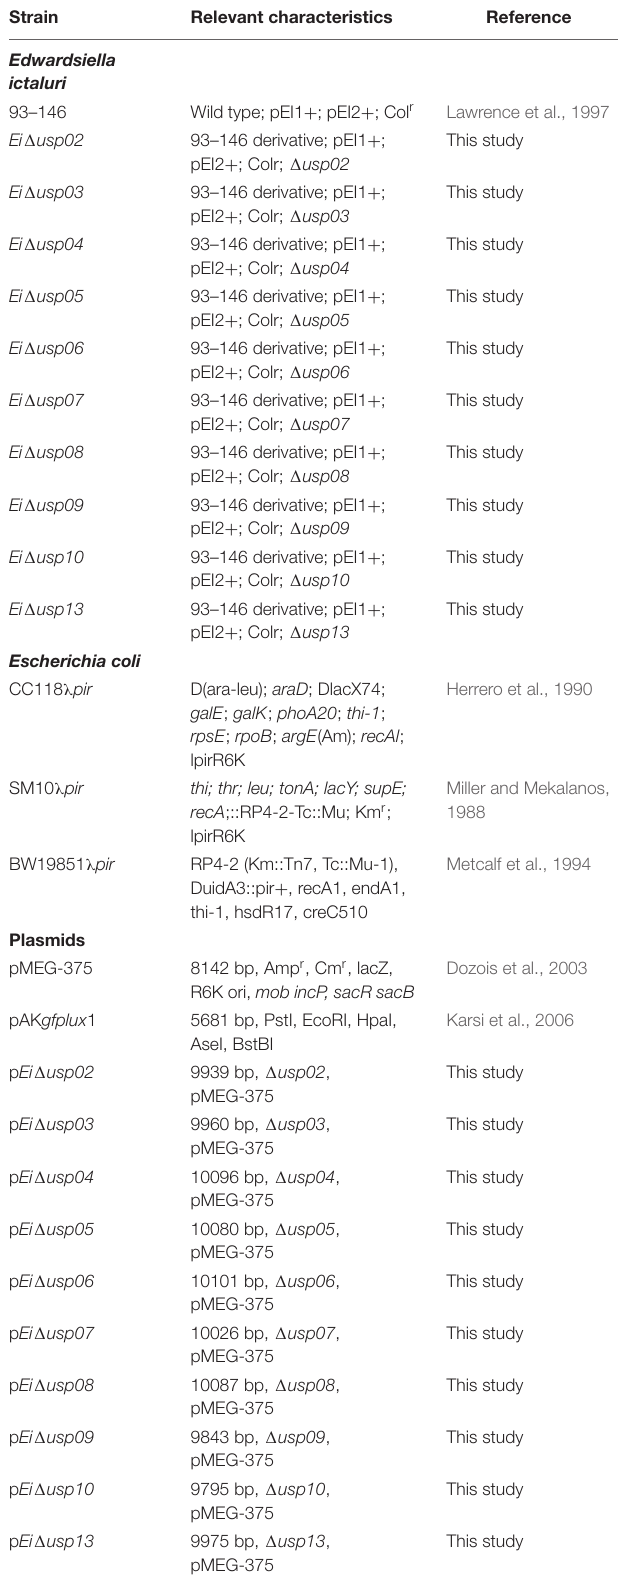
TABLE 1 | Bacterial strains and plasmids used in this